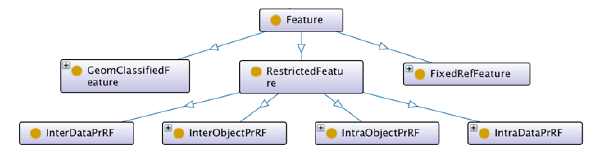
Figure 5. RestrictedFeature class and its subclasses.